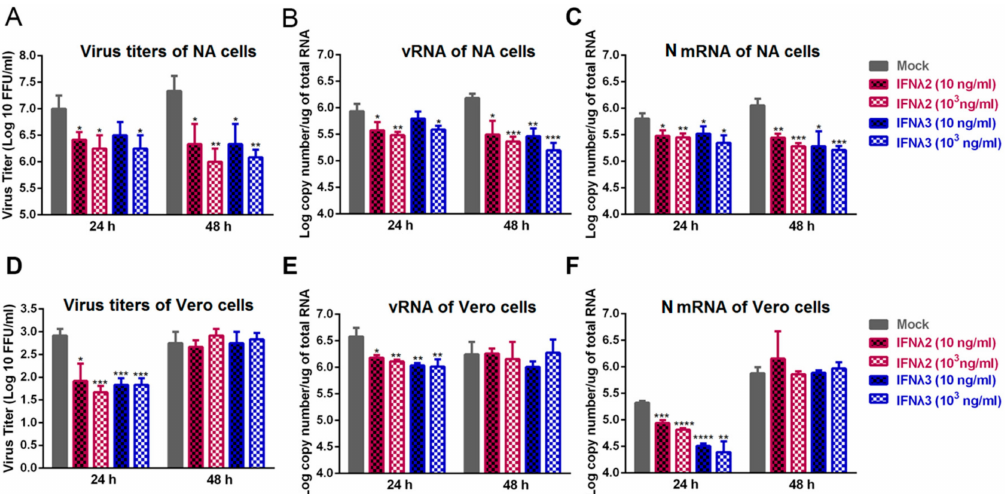
Figure 1. Treatment with IFN- λ inhibits RABV replication in vitro. NA or Vero cells were infected with B2c at a multiplicity of infection (MOI) of 0.01, and recombinant mouse IFN- λ 2 or IFN- λ 3 at 10 ng / mL and 1000 ng / mL was added to treat the B2c infected NA or Vero cells at 24 h post infection (hpi). Cell supernatants were harvested at 24 h and 48 h after the treatment for virus titration on NA cells ( A ) or Vero cells ( D ). The production of vRNA in NA cells ( B ) or Vero cells ( E) was measured by qRT-PCR. RABV N transcription levels in NA cells ( C ) or Vero cells ( F) were determined by qRT-PCR. Error bars represent the standard error (SE, n = 3). The following notations were used to indicate significant di ff erences between groups: *, p < 0.05; **, p < 0.01; ***, p < 0.001; ****, p <